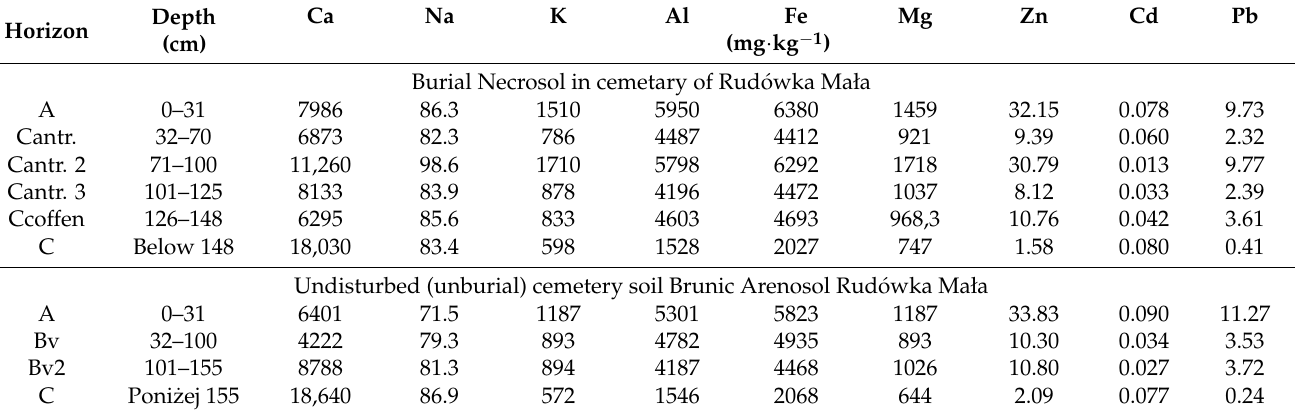
Table 3. Total composition of selected major and trace elements in cemeteries in Rud ó wka